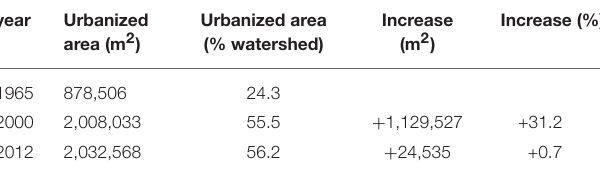
TABLE 6 | Quantitative urbanization changes in the Pozzuoli watershed during the 1965–2012 time span.